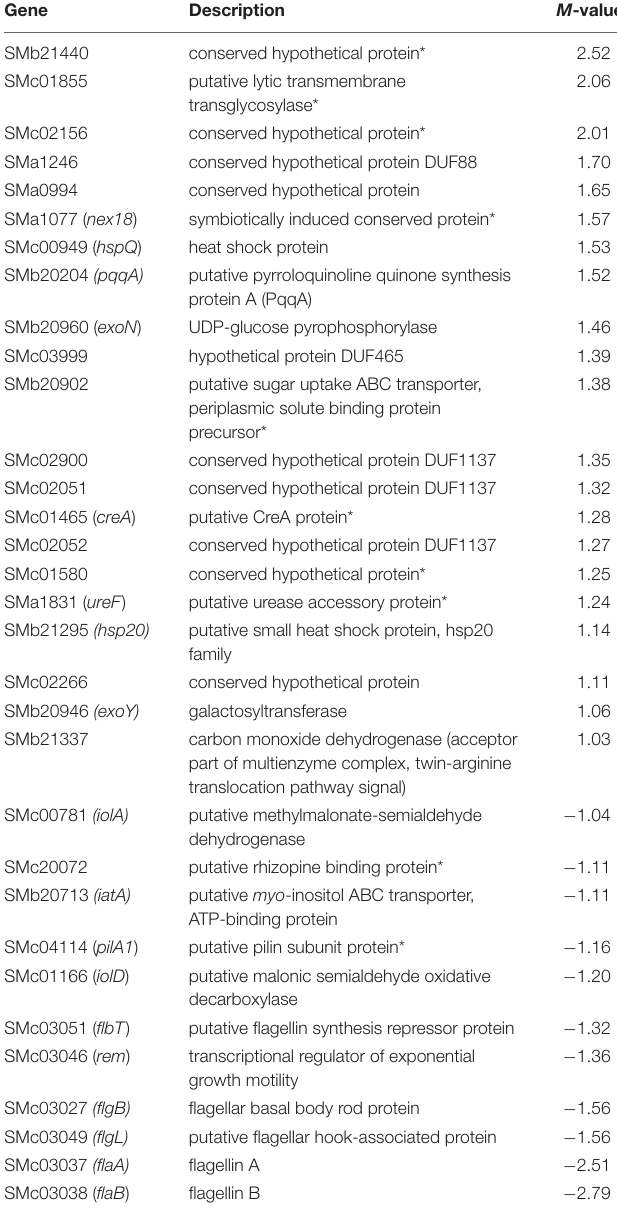
TABLE 3 | Partial list of Sinorhizobium meliloti genes differently expressed in the phosphatidylcholine-deficient mutant OG10017 (M > 1 or M < −